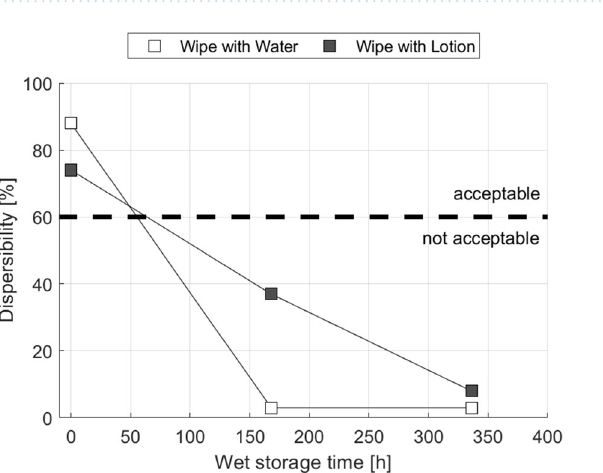
Figure 1. Slosh box principle: ( a ) top view of slosh box with a wipe (125 × 175 mm), ( b ) scheme of slosh box side view with maximum tilting amplitude, ( c ) 12.5 mm hole sieve, 200 µm mesh sieve and both sieves stacked on top of each other with a distance of 27 mm.